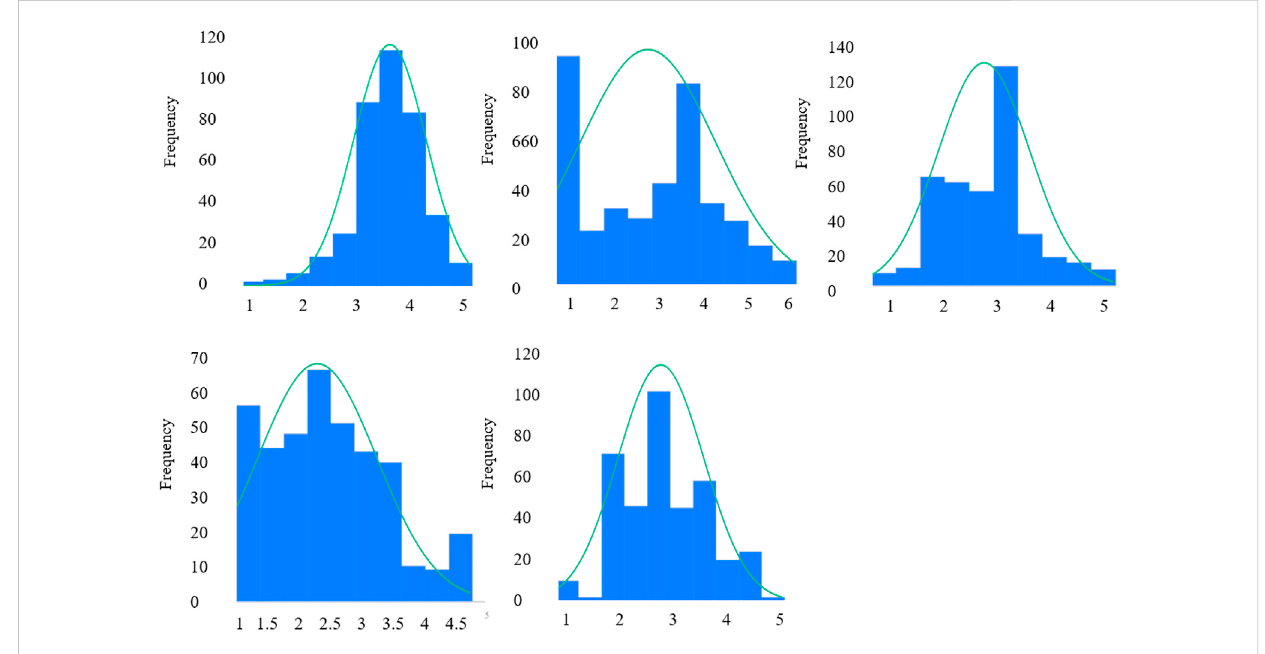
FIGURE 4 Normality test histogram for different income levels.